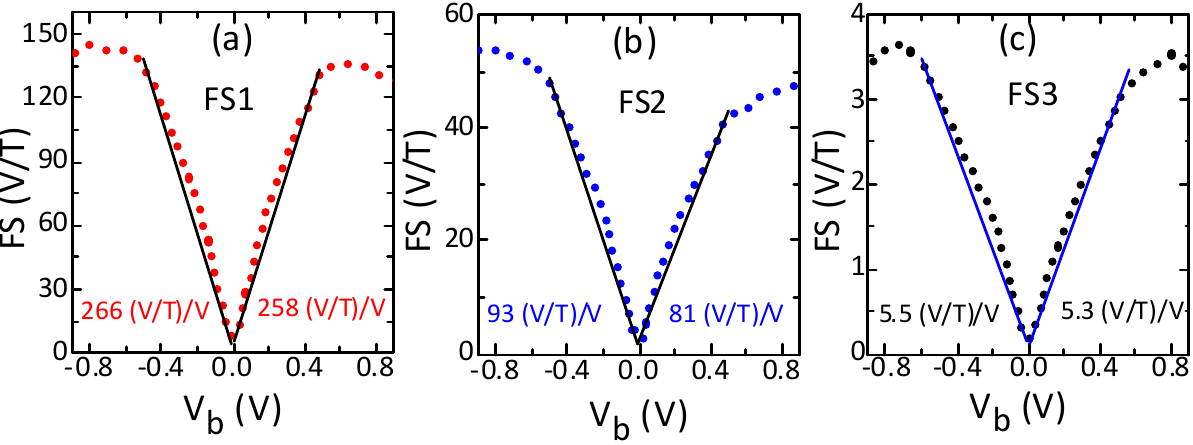
Figure 2. Bias voltage influence on the field sensitivity (FS) of the sensors with high ( a ), medium ( b ) and low ( c ) sensitivity. The sensitivity increases linearly up to a certain bias but with higher rate under negative polarity. It also reaches a higher maximum value under negative polarity. The linear ranges of sensitivity were determined by fitting the linear model to the measured data using the least squares method. Solid lines represent the linear fits and the dotted lines are the experimental